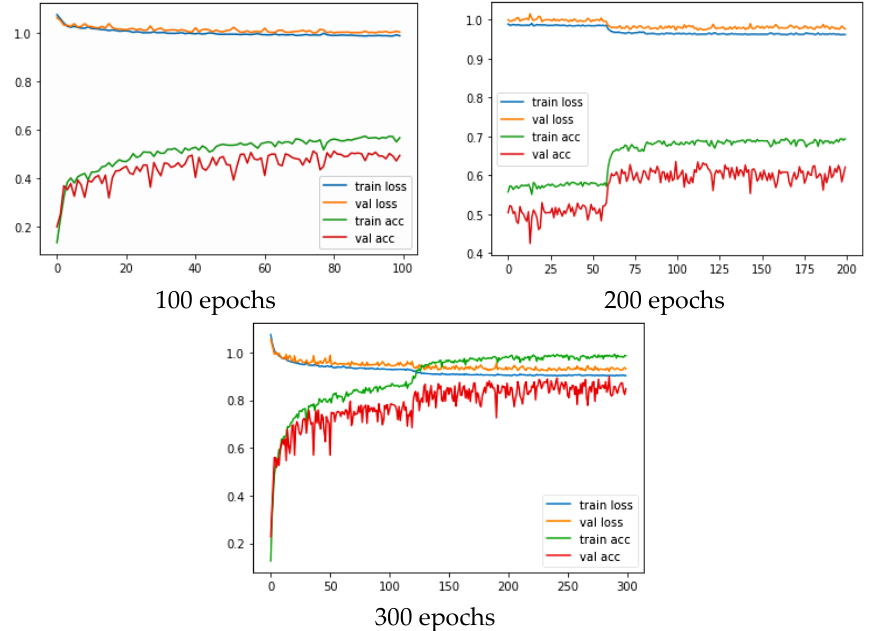
Figure 4. Graphical representation of the performance of the CNN model.